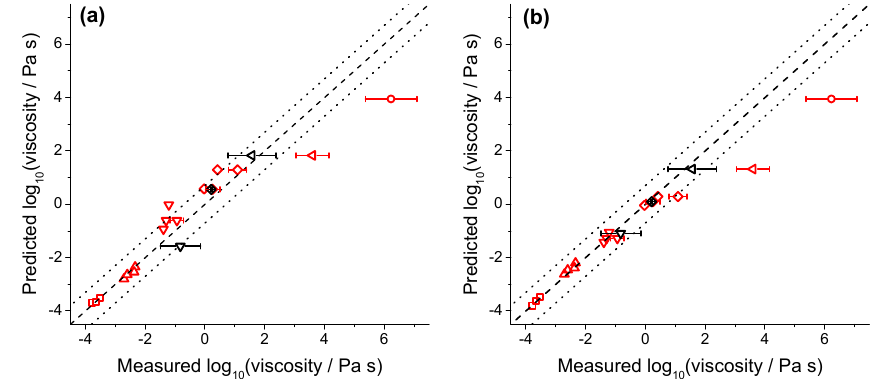
Figure 8. Plot of measured vs. predicted log 10 (viscosity) using the models of (a) Sastri and Rao (1992) and (b) Marrero-Morejon and Pardillo-Fontdevila (2000) for the C 3 –C 6 alkanes (square symbols), alcohols (upward-pointing triangles), diols (downward-pointing trian- gles), triols (diamonds), tetrols (leftward-pointing triangles), and hexaol (circle) shown in Fig. 3. Values determined experimentally in this study are shown in black, whilst literature viscosity values are shown in red. Dashed lines correspond to the 1:1 lines and dotted lines correspond to 1:5 and 5:1 lines. Error bars indicate uncertainties in the measured